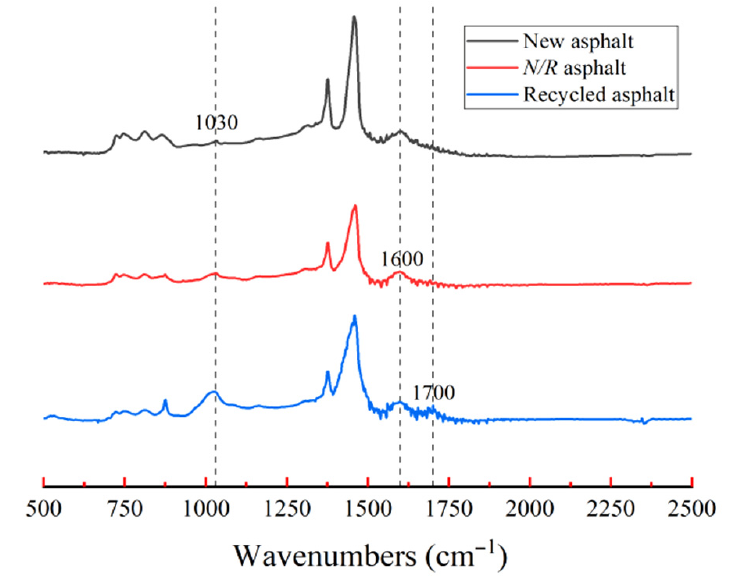
Figure 2. Infrared spectra of three original asphalts.